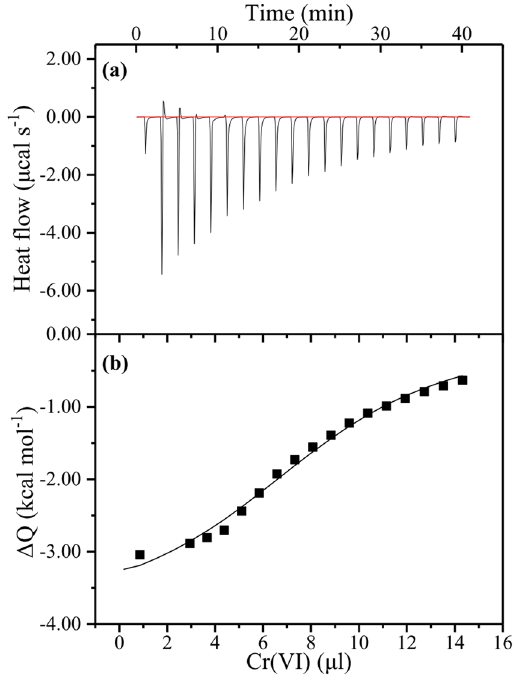
Figure 5. Calorimetric titration of Cr(VI) with EPS in Tris-HCl buffer at 298.15 K. ( a ) Heat released per injection of Cr(VI) in the ITC experiments; ( b ) non-linear regression of the heat vs Cr(VI) dosage.